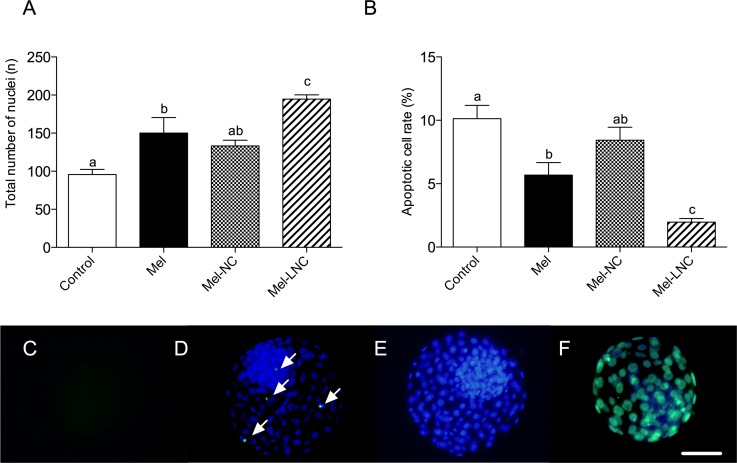
Effects of free and nanoencapsulated melatonin (10−9 M) on total cell number and cell apoptosis in blastocysts.Effect of treatment on total cell number (A), and apoptotic cell rate in blastocysts (B). Data represent mean ± S.E.M. Different letters above the error bars indicate significant differences between groups (P< 0.05). Representative images of negative control (C), apoptotic cells indicated by arrows (D), total cell number (E), and positive control embryo with both nuclear and TUNEL staining (F). Scale bar = 50 μm. Magnification = 100X.